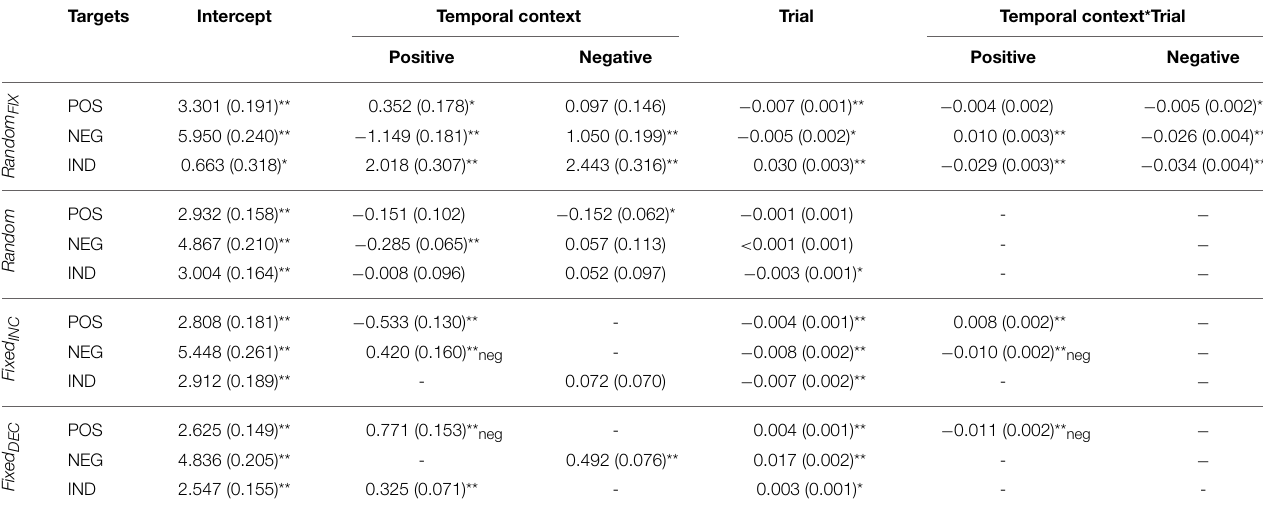
TABLE 2 | Fixed effects parameter estimates for arousal ratings, for the entire sample